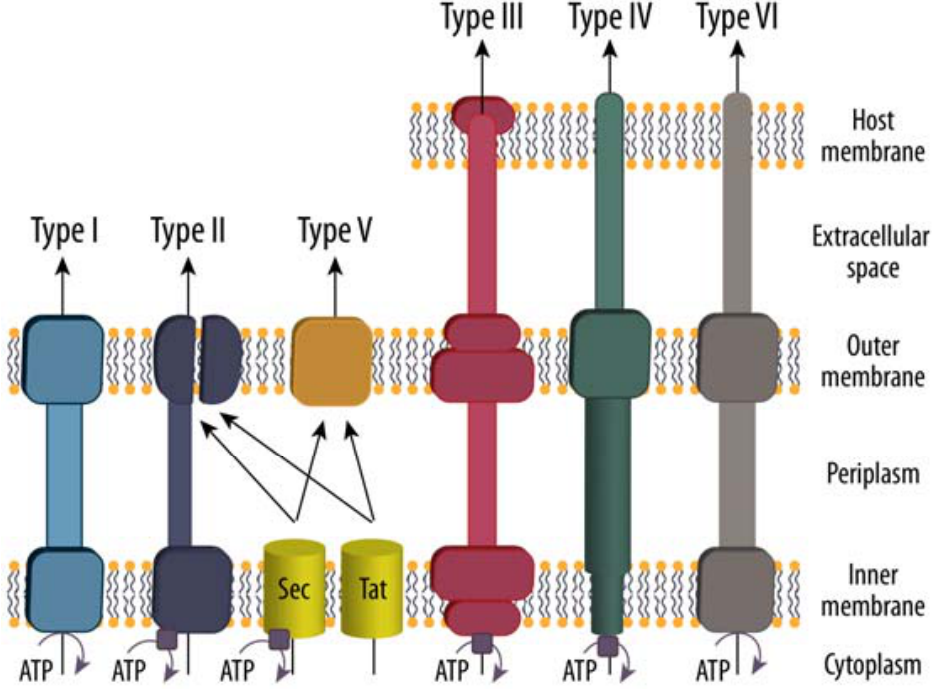
Figure 3. Schematic overview of known secretion systems in Gram-negative bacteria. The basic structural features of the type I (T1SS), type II (T2SS), type V (T5SS), type III (T3SS), type IV (T4SS), and type VI (T6SS) secretion systems are depicted, with the latter three being capable of directly injecting effector proteins into host cells. Sec (general secretion route) and Tat (twin-arginine translocation pathway) transfer unfolded and folded substrates of T2SS and T5SS across the inner membrane, respectively. The other secretion systems are one-step mechanisms that transport their cargo directly from the bacterial cytosol to the extracellular space or into eukaryotic host cells. Importantly, Sec and Tat are sufficient to cross the single bacterial membrane and reach the surface-exposed peptidoglycan layer in Gram-positive bacteria. Figure adapted from